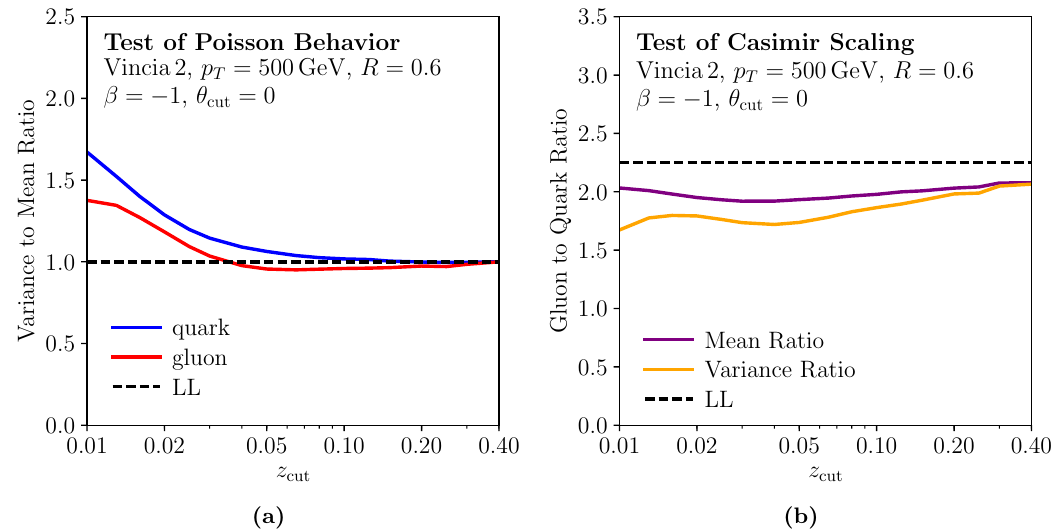
Figure 6. (a) Variance to mean ratio of the soft drop multiplicity as a function of z parameters (cid:12) and (cid:18) cut are set to the benchmark values in eq. (2.7), and the LL prediction of equal mean and variance is shown as a dashed line. (b) Gluon to quark mean ratios and variance ratios, with the prediction of Casimir scaling shown as a dashed line. In both cases, we see qualitative agreement between Vincia and the LL predictions down to z cut = 0 : 02.